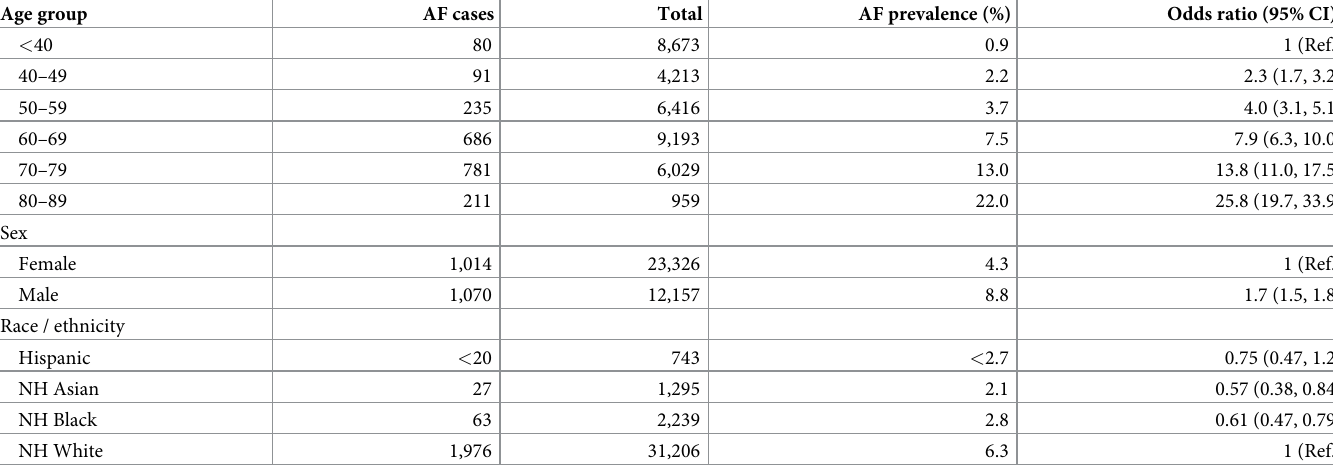
Table 2. Prevalence of self-reported atrial fibrillation (AF) by age, sex, and race/ethnicity, All of Us Research Program, 2017–2019. Age group